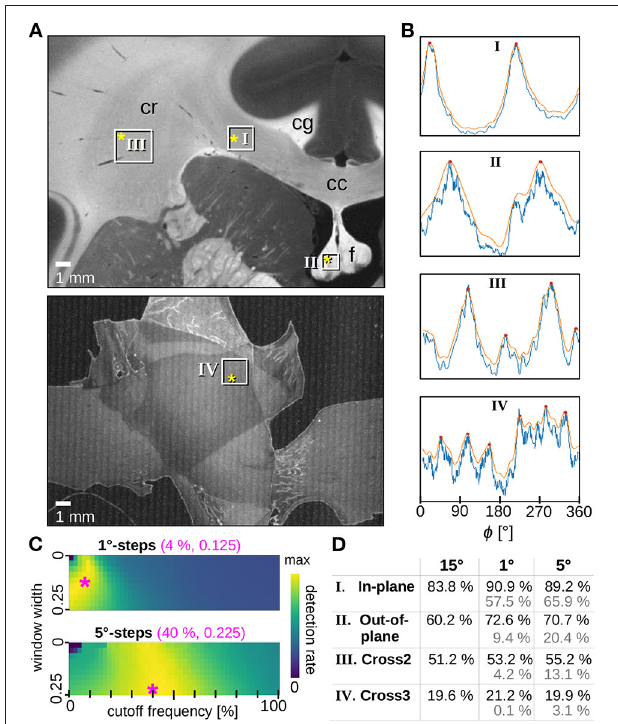
FIGURE 2 | Optimized smoothing of SLI profiles. (A) Averaged scattered light intensity of a coronal vervet monkey brain section (section 493, top) and three crossing sections of human optic tracts (sections 32/33, bottom). The white rectangles mark the evaluated regions containing mostly (I) in-plane, (II) out-of-plane, (III) two times crossing, (IV) three times crossing nerve fibers. Relevant anatomical structures are labeled: corpus callosum (cc), cingulum (cg), corona radiata (cr), fornix (f). (B) Examples of original (blue) and smoothed (orange) SLI profiles (normalized by their maximum value) with 1φ = 1 ◦ -steps, obtained from scattering patterns measured at locations indicated by the yellow asterisks in A. The SLI scatterometry measurements were performed with one illuminated LED and 10 s illumination. For the vervet brain section, the measurement was performed 16 months after tissue embedding with 64 × 64 kernels and a gain factor of 27. For the three sections of optic tracts, the measurement was performed 20 months after tissue embedding with 50 × 50 kernels and a gain factor of 10. (C) Detection rate (average over the four selected tissue types) for different parameters of the Fourier low pass filter (different cutoff frequencies and windows widths) applied to the SLI profiles generated with 1φ = 1 ◦ -steps (top) and 5 ◦ -steps (bottom). The magenta asterisks mark the set of parameters (shown in magenta numbers) for which the maximum detection rate is reached: 83.4% for 1 ◦ -steps and 80.8% for 5 ◦ -steps. (D) Detection rates were evaluated separately for the different regions in (A) . The black numbers show the detection rates for SLI profiles with 15 ◦ -steps (without smoothing) as well as for SLI profiles with 1 ◦ - and 5 ◦ -steps when using the optimum smoothing parameters (magenta numbers in C ). The gray numbers show the detection rates before applying the